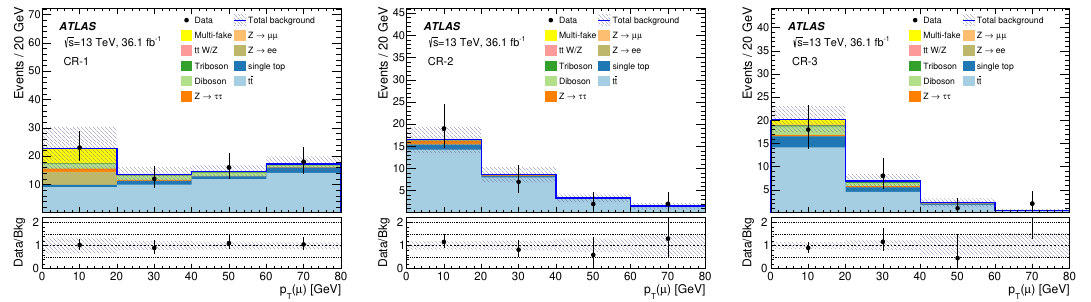
Figure 4. Third-lepton p T distributions in the control regions CR-1 (left), CR-2 (middle) and CR- 3 (right) for the prompt HNL analysis in the electron channel, showing post-(cid:12)t background-only hypothesis including all the uncertainties and normalised in both CRs+SR. The total uncertainty in the background is shown as dashed regions.